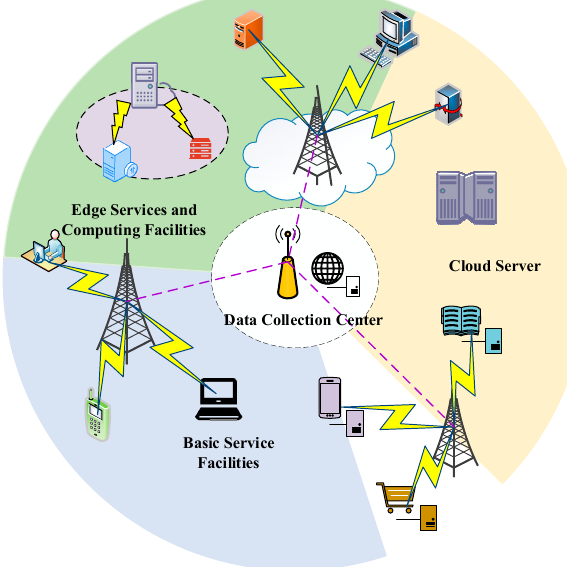
Figure 2. Schematic architecture of the MEC